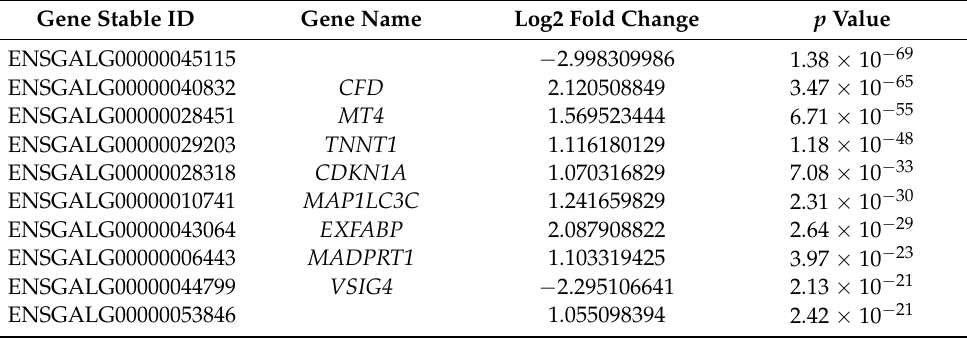
Table 1. Top ten differentially expressed genes (DEGs) in CFM_KO vs. CFM_WT. Gene Stable